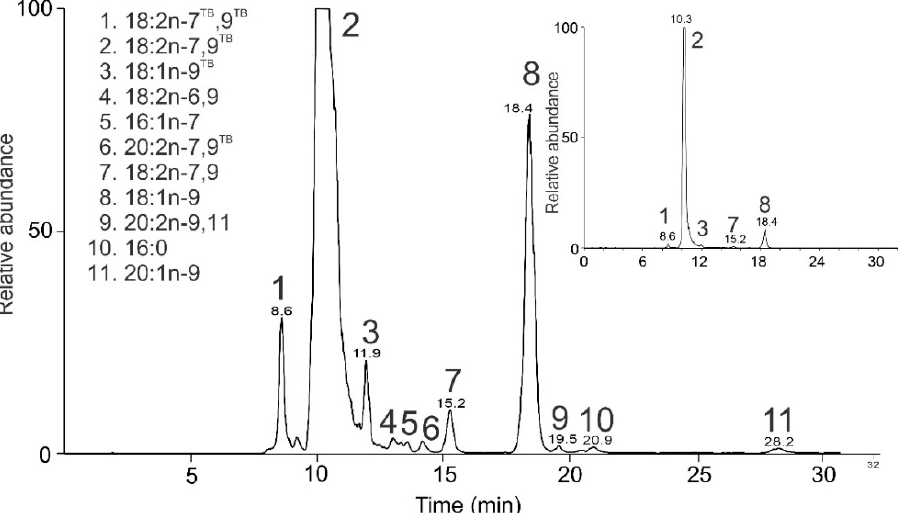
bond in the position n-7. Low-intensity fragment ω n-7 was detected at m/z 166.1. The